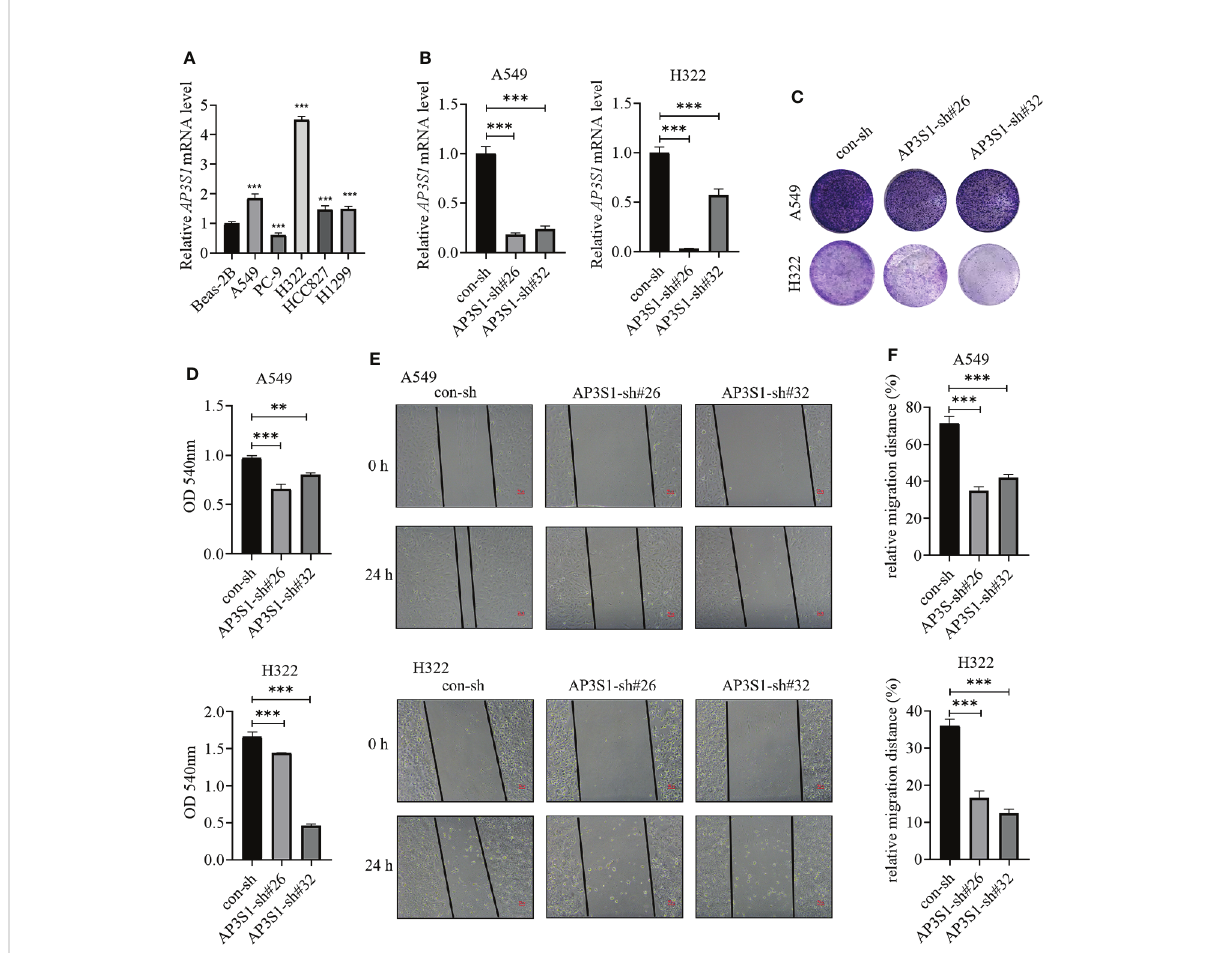
FIGURE 12 Expressions of AP3S1 in LUAD cells and its function. (A) AP3S1 mRNA levels in Beas-2B and LUAD cells. (B) The mRNA levels of AP3S1 in A549 and H322 LUAD cells after its knockdown. (C, D) Colony formation assays were used to assess the functions of AP3S1 silenced in LUAD cells. Representative images were shown in (C) . (E, F) Knockdown of AP3S1 inhibits the migration of LUAD cells. The wound healing assay was performed to examine the migration of A549 and H322 cells with AP3S1 expression being silenced. Representative images were shown in (E) . ** p <0.01, *** p <0.001. All experiments were repeated at least three